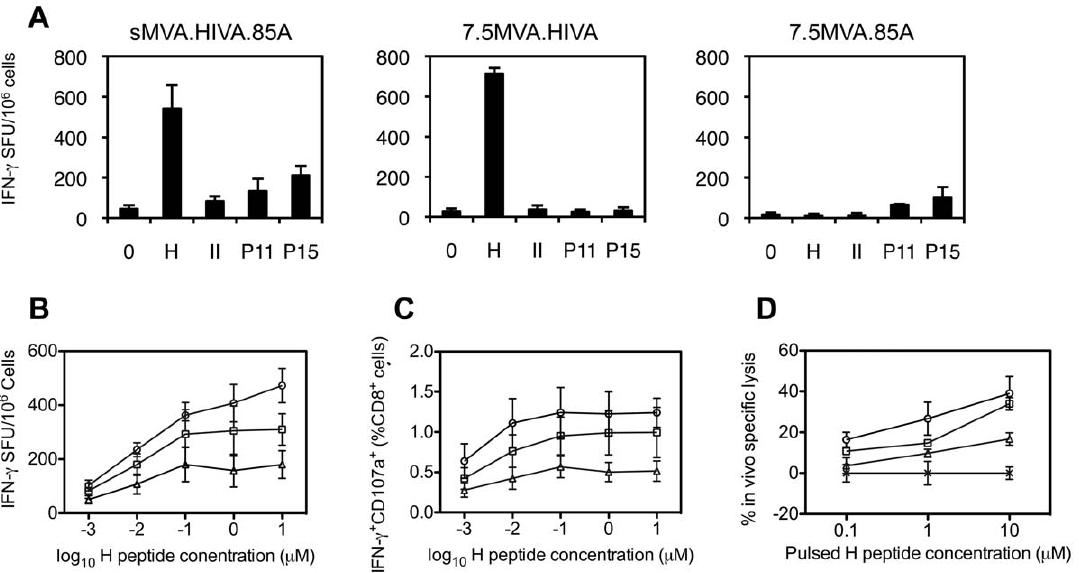
Figure 3. Induction of HIV-1- and M.tuberculosis -specific T cell responses. ( A ) Groups of 4 BALB/c mice were immunized with 10 7 PFU i.m. of either 7.5MVA.HIVA, 7.5MVA.85A or sMVA.HIVA.85A, sacrificed 2 weeks later and splenocytes from individual mice were analyzed for IFN- c production following peptide stimulation. Data are represented as means 6 SD. ( B–C ) Groups of 4 BALB/c mice were immunized i.m. with 10 5 PFU of either 7.5MVA.HIVA (triangles), mMVA.HIVA.85A (circles) or sMVA.HIVA.85A (squares) vaccines. Two weeks later, mice were sacrificed and the ability of splenocytes from individual animals to respond to increasing amounts of peptide H was assessed in an IFN- c ELISPOT ( B ), ICS ( C ) and in vivo killing ( D ) assays. Mean 6 SD are shown. Only stimulation with 1 m M H peptide in an IFN- c ELISPOT assay provided a statistically significant difference ( p =0.04) between frequencies induced using the mH5 and ssp promoters.